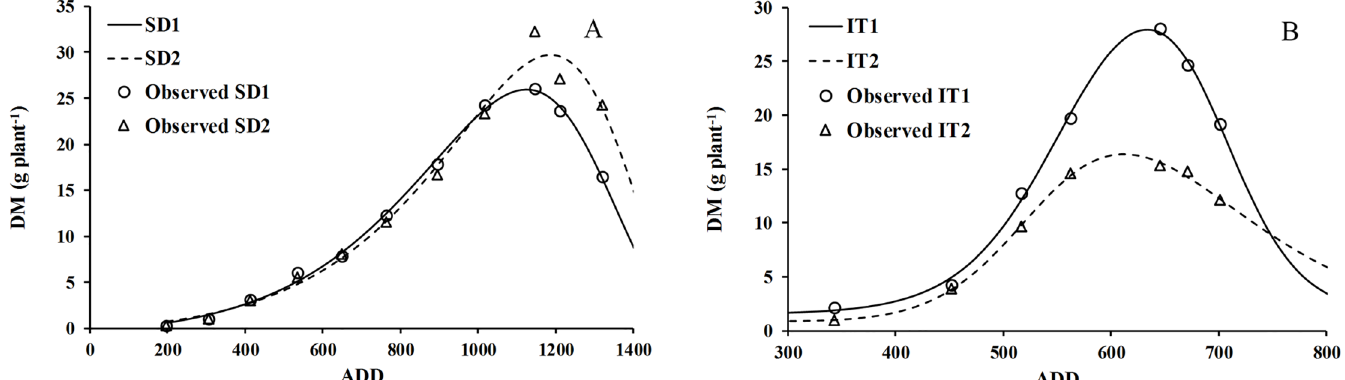
Fig 4. Evolution of the dry biomass (g plant -1 ) during the chia crop cycle (points). Curves were adjusted using a double logistic function (lines), as a function of accumulated degree days (ADD) for sowing date (A) and water availability (B) in chia plants established in Antumapu and Intihuasi, respectively.